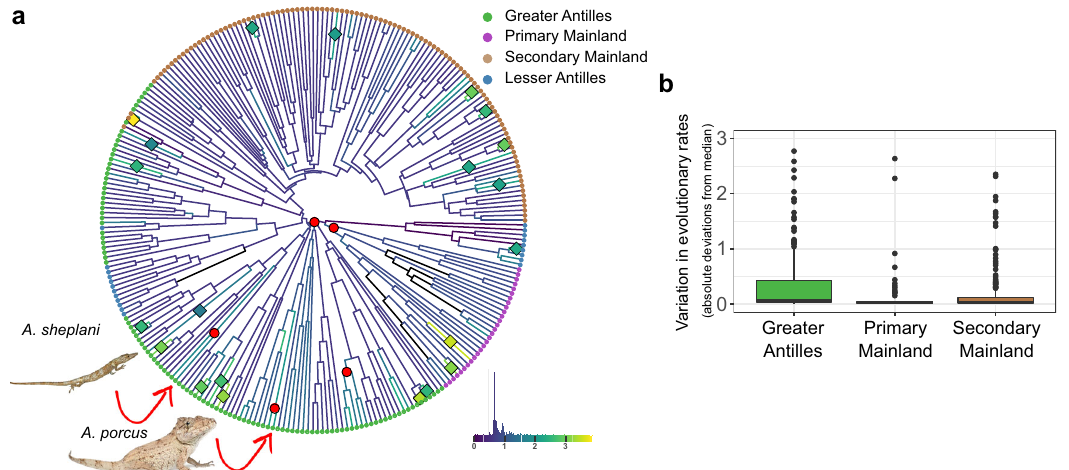
Fig. 3 Evolutionary rates are more variable in Greater Antillean Anolis. a Phylogenetic tree summarizing the results of the rjMCMC variable rate analysis estimating the propensity of edges and nodes to vary in evolutionary rates. Colored dots at the tips indicate to which biogeographic group a given species belongs. Diamonds in the phylogeny mark the position of branch shifts and red circles the position of node shifts that were identi fi ed in the majority of the posterior samples. Branch colors indicate relative evolutionary rates (log-transformed) and the histogram (bottom right) summarizes the frequency distribution of individual branches. Pictures show an A. sheplani (picture provided by Alejandro J. Sánchez) and an A. porcus (picture sourced from “ Alamy Limited ” ). b Box plot summarizing the variance in evolutionary rates per branch of the full dataset as absolute deviations from the median for each major group. Colored boxes span the interquartile range with the median indicated by a horizontal line, whiskers represent 1.5 times the interquartile range, and outliers are represented by dots. Number of branches per group are n = 229 for Greater Antilles, n = 58 for Primary Mainland, and n = 208 for Secondary Mainland. Brown – Forsythe tests for equality of variance followed by Tukey post hoc tests (both two-sided) revealed that the Greater Antillean group showed a signi fi cantly higher variance than the Secondary Mainland clade (Supplementary Tables 12 and 13 give the full report of the statistical